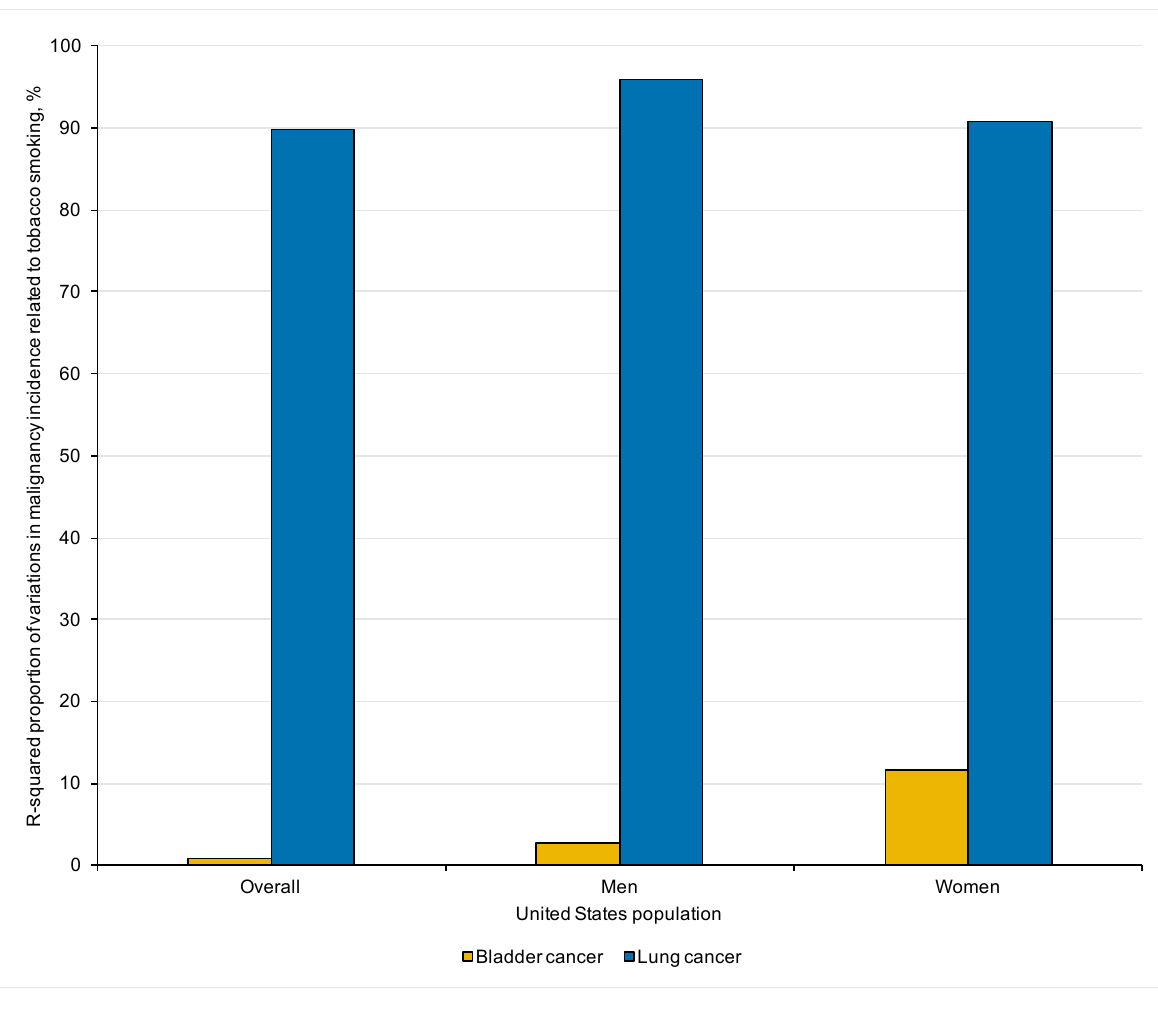
Figure 3. Proportions of variations in bladder and lung cancer incidence related to tobacco smoking exposure in the overall, male, and female United States populations over the past-half century. Table 1. Annual percent changes, incidence rate differences, and R-squared statistics in the overall, male, and female United States populations.